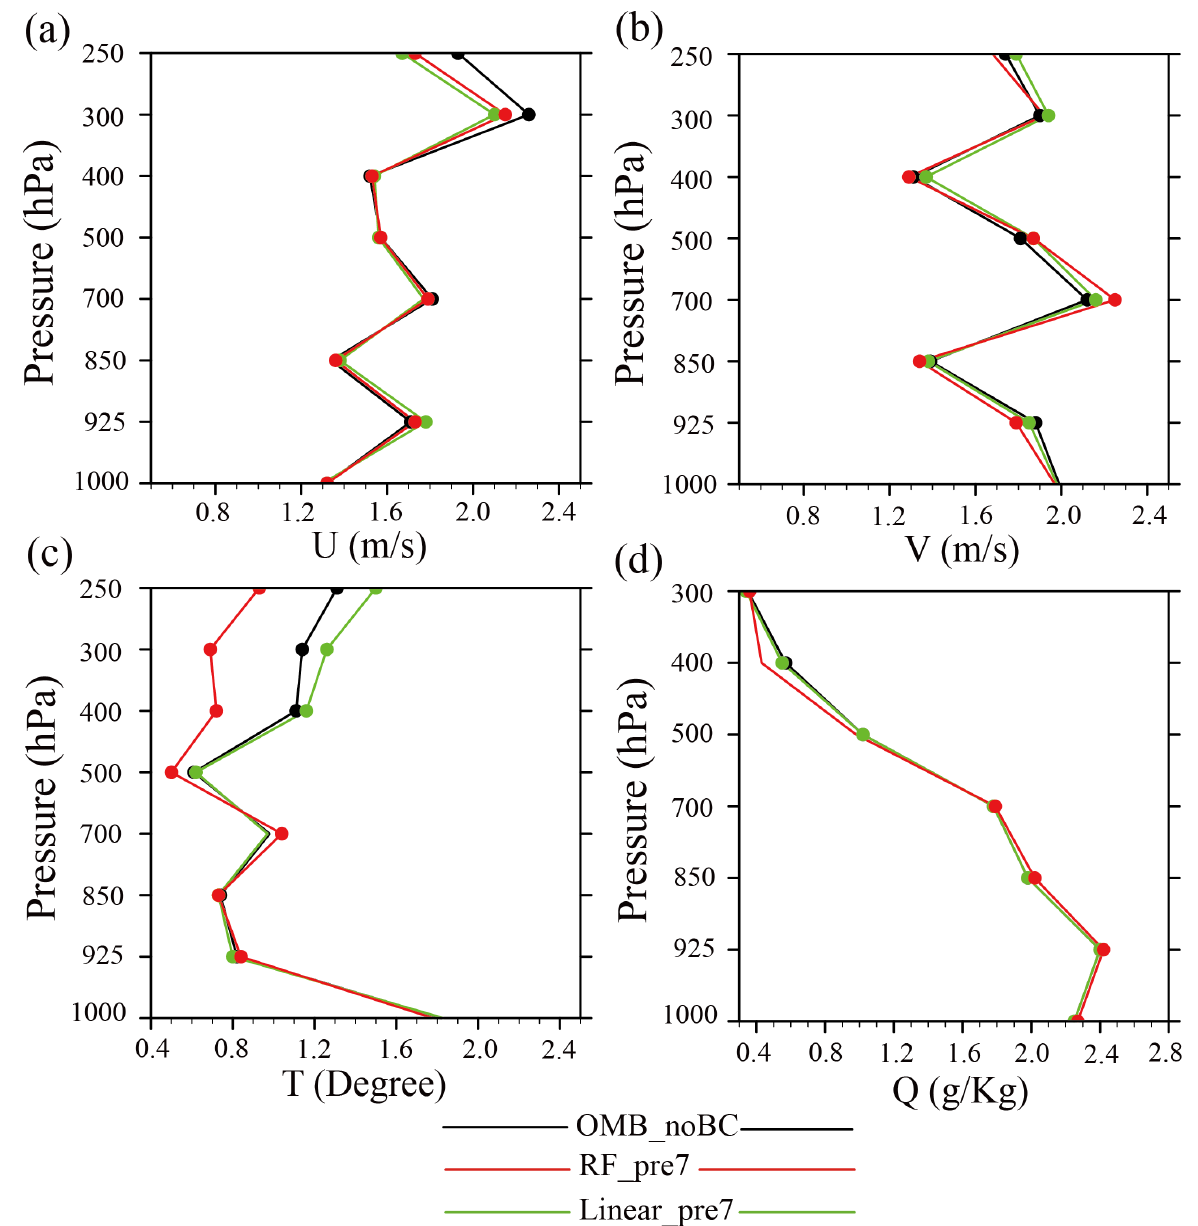
Figure 13. The root-mean-square error (RMSE) vertical profiles of the analyses with the radiances of AGRI channels 9–10 from the OMB_noBC (black lines), RF_pre7 (red lines), and Linear_pre7 (green lines) experiments, respectively, verified against the sounding and surface synoptic observations for ( a ) U-wind, ( b ) V-wind, ( c ) temperature, and ( d ) specific humidity valid at 0600 UTC 20 July 2021. The marked dots show a significance level above 95%.